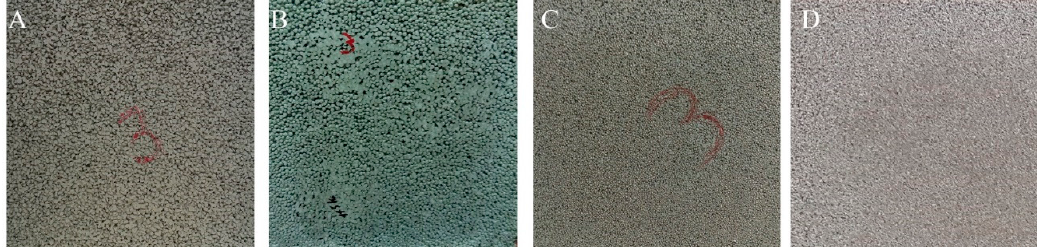
Figure 6. Back surface for Sample ( A ): crushed normal weight aggregates 4–8 mm; Sample ( B ): round lightweight aggregates 4–8 mm; Sample ( C ): round lightweight aggregates 2–4 mm; Sample ( D ): round lightweight aggregates 0.5–1 mm.